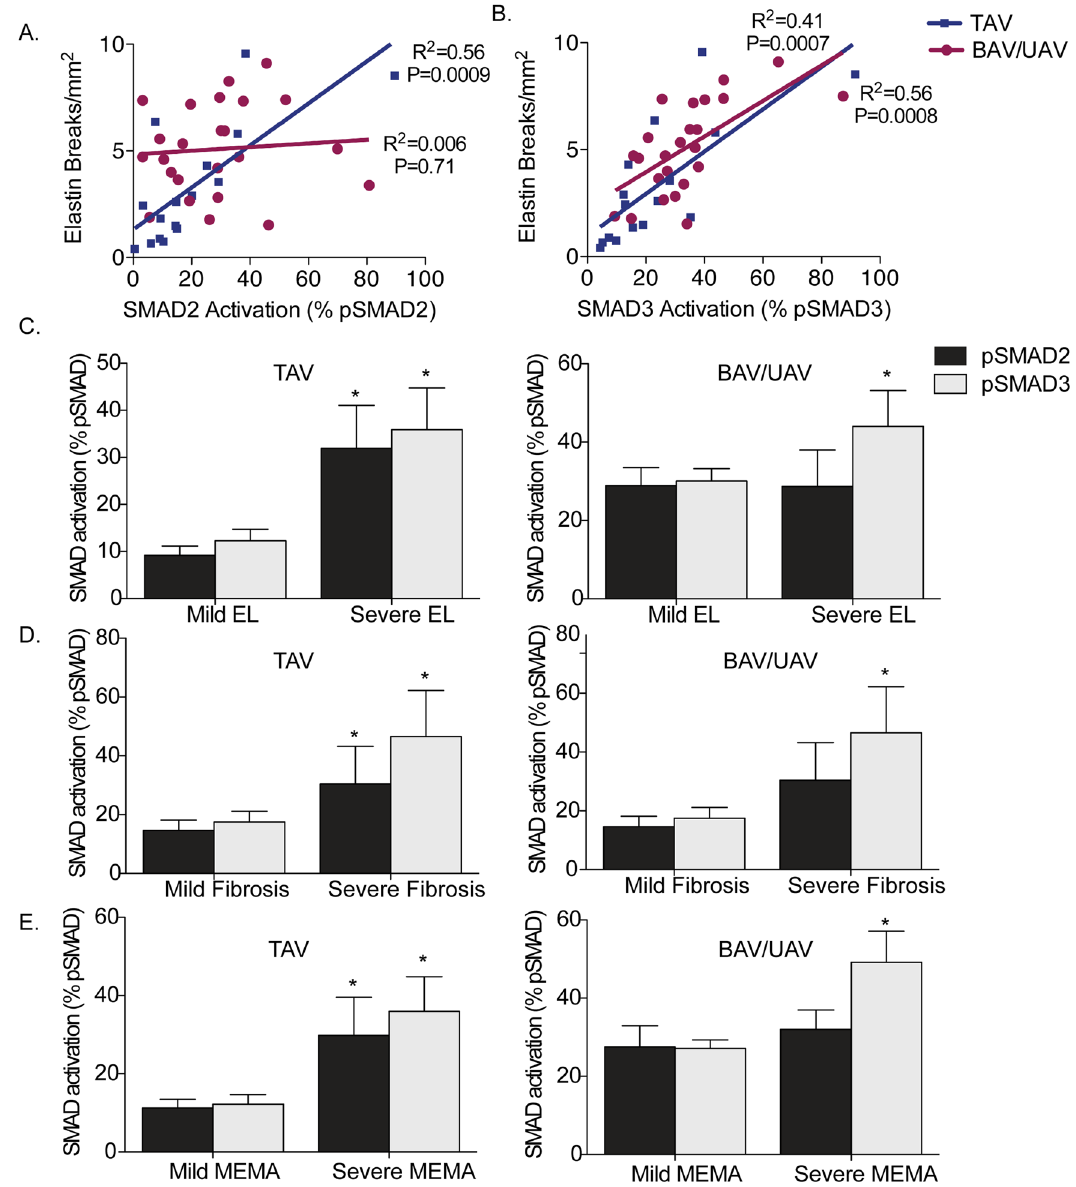
Figure 6. Aortic remodeling is dependent upon phosphorylation of SMAD3, but not SMAD2 in bicuspid (BAV) and unicuspid (UAV) aortic valve-associated ascending aortic aneurysms. ( A ) Graph depicting the relationship between elastin breaks and phosphorylated SMAD2 (pSMAD2) in TAV (blue) and BAV/UAV (pink) aortas. ( B ) Graph depicting the relationship between elastin breaks and phosphorylated SMAD3 (pSMAD3) in TAV (blue) and BAV/UAV (pink) aortas. ( C – E ) Graphs depicting the level of pSMAD2 (dark grey) and pSMAD3 (light grey) in ascending aortas with mild or severe elastin loss (EL; C ), fibrosis ( D ) and mucoid extracellular matrix accumulation (MEMA; E ) in TAV (left) and BAV/UAV (right) aortas. *P <